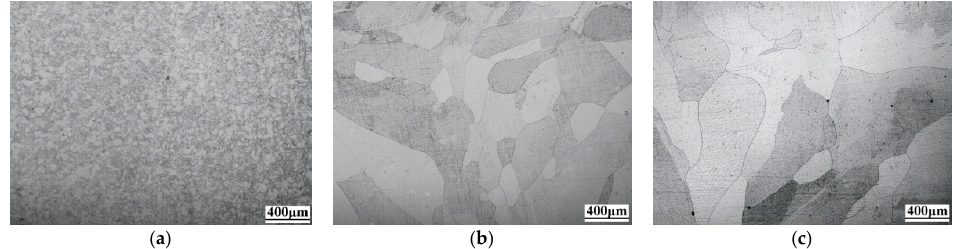
Figure 2. Optical micrographs showing the microstructure of ( a ) BM (base metal); ( b ) J P ; and ( c ) J P-T .